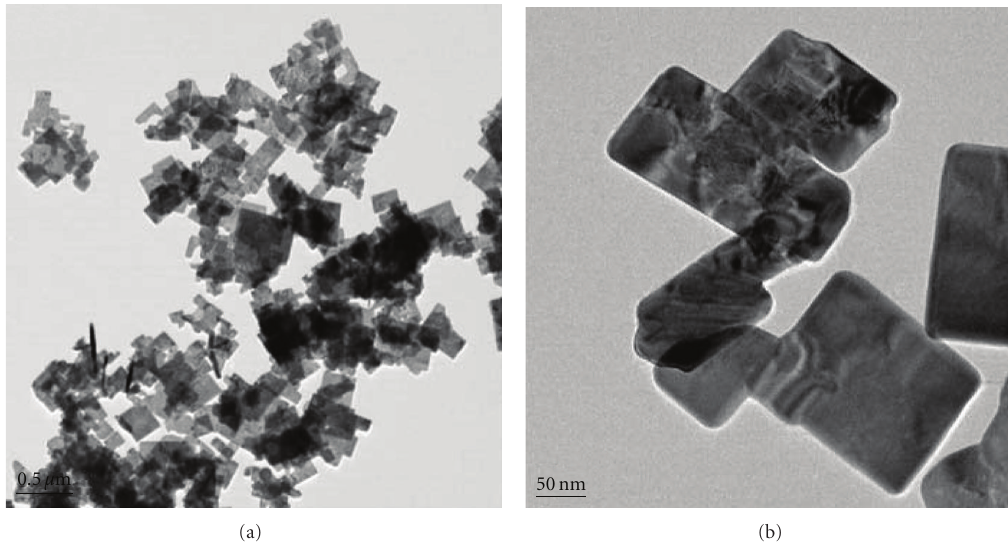
Figure 3: The TEM images of as-synthesized Bi 2 WO 6 nanoplates: (a) low magnification, (b) high magnification.